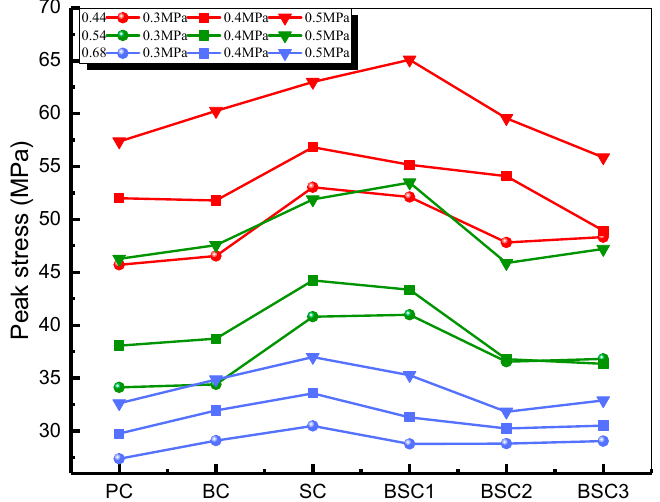
Figure 16. Fiber hybridization effect on impact strength of BSFRC.